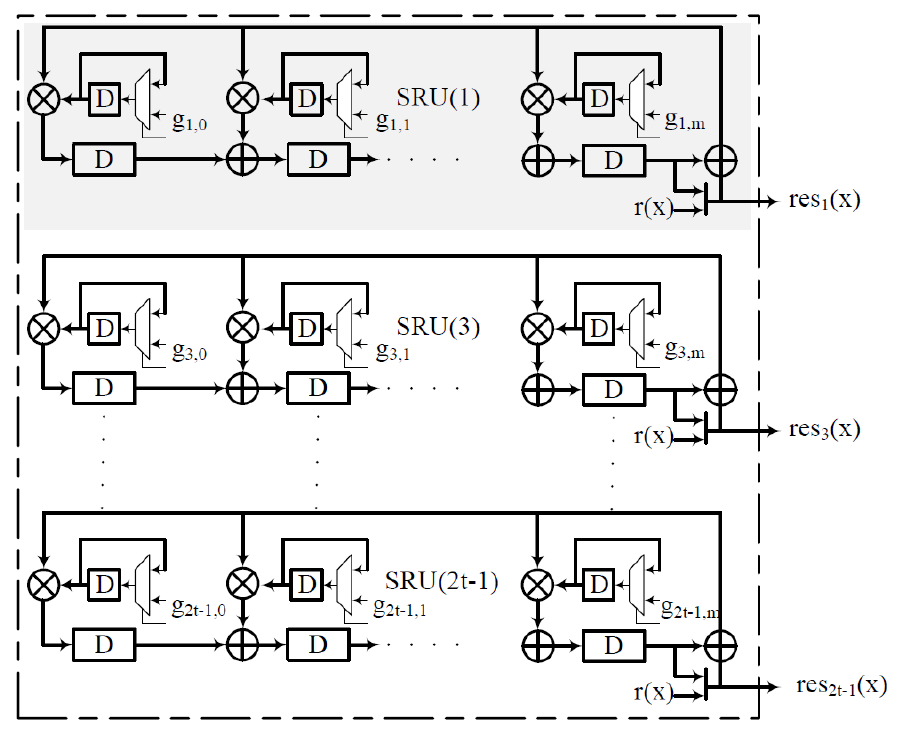
Figure 4. Array of the syndrome residual